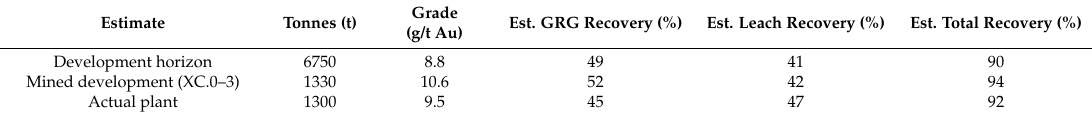
Table 16. Estimated gold recovery and achieved values in the SVZ.